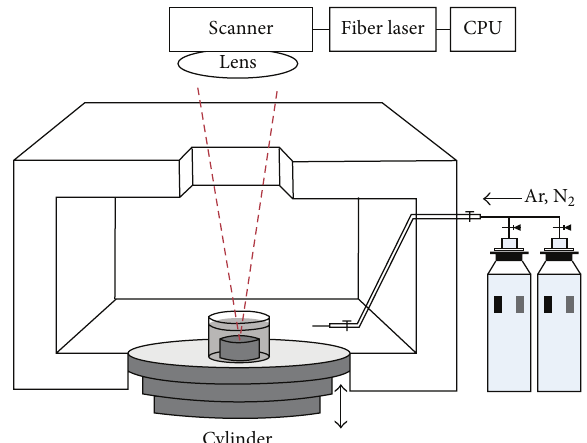
Figure 1: Schematic drawing of direct laser hardening system.